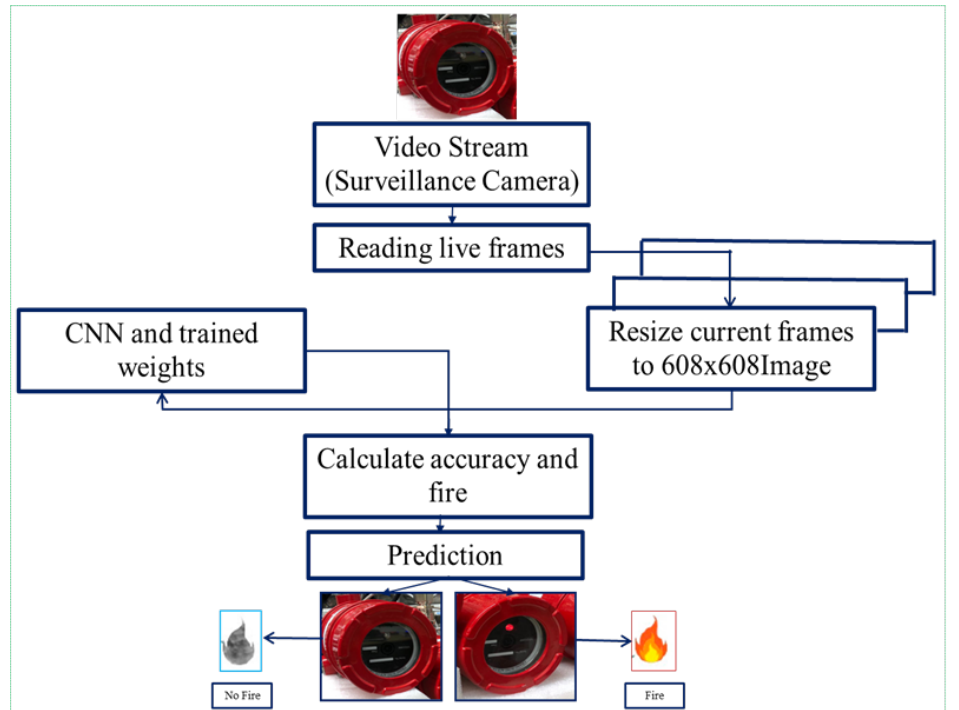
Figure 3. Overall process of the proposed method.